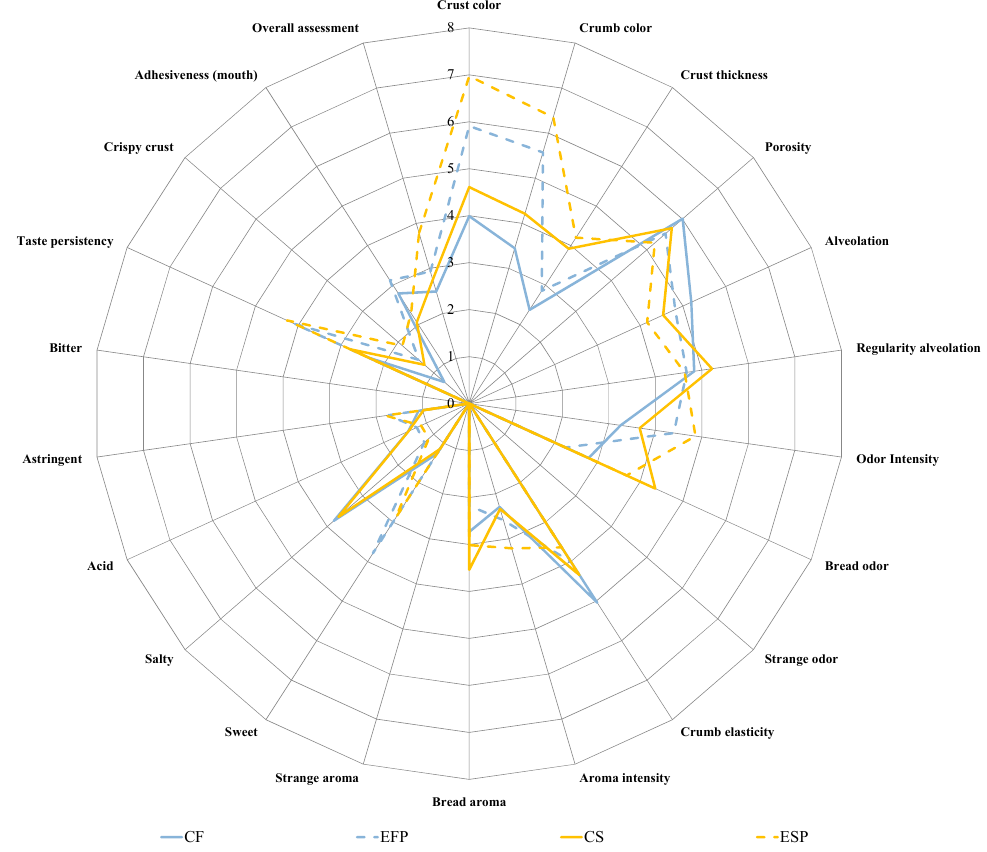
Figure 3. Spider diagrams of descriptive sensory evaluation of breads. Abbreviations: CF, control